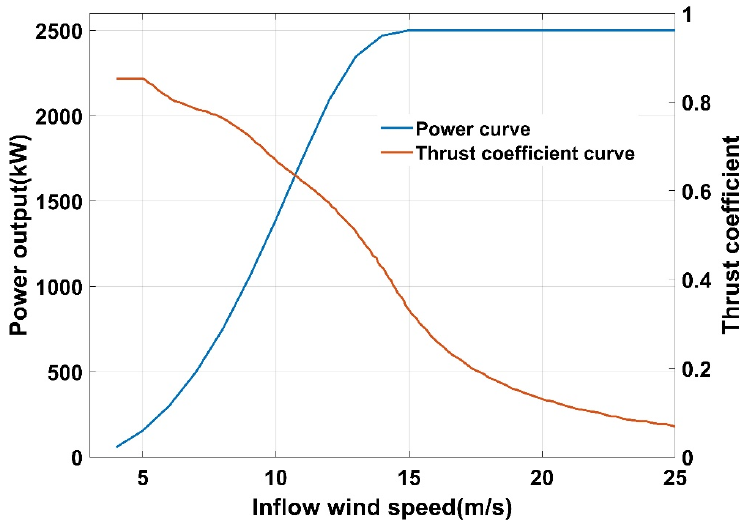
Figure 10. Power curve and thrust coefficient curve of Nordex 2.5 MW. Different from the layout types of the previous two wind farms, the ECN test wind farm is an onshore wind farm with a tight spacing arrangement. The downstream-located wind turbines are fully or partially covered by the wake of the upstream machines when the angle of the wind direction is measured within a deviation angle of ±3°. Hence, grids distribution of the computational domain with the inflow wind direction of 275 ± 3° (presented in Figure 11) can be divided into two grid distributions with a wind direction of 275° and 278°, based on the grid independence study in Section 2.4. Since the computational domain grid with the inflow wind direction of 272° is symmetrical to that with the wind direction of 278°, it is no longer shown here. The upper part is the grid of the computational domain with a wind direction of 275°, and the total number of cells is 2,150,148. The number of cells in the streamwise direction is 369; 80 nodes are distributed vertically, and the number of nodes in the spanwise direction is also 80. The lower part is the grid distribution of the computational domain with a wind direction of 278°. Its total number of cells is 2,443,584. The number of grid nodes in the flow direction is 363, the number of nodes in the vertical distribution is 80, and the number of cells in the spanwise direction is 92.